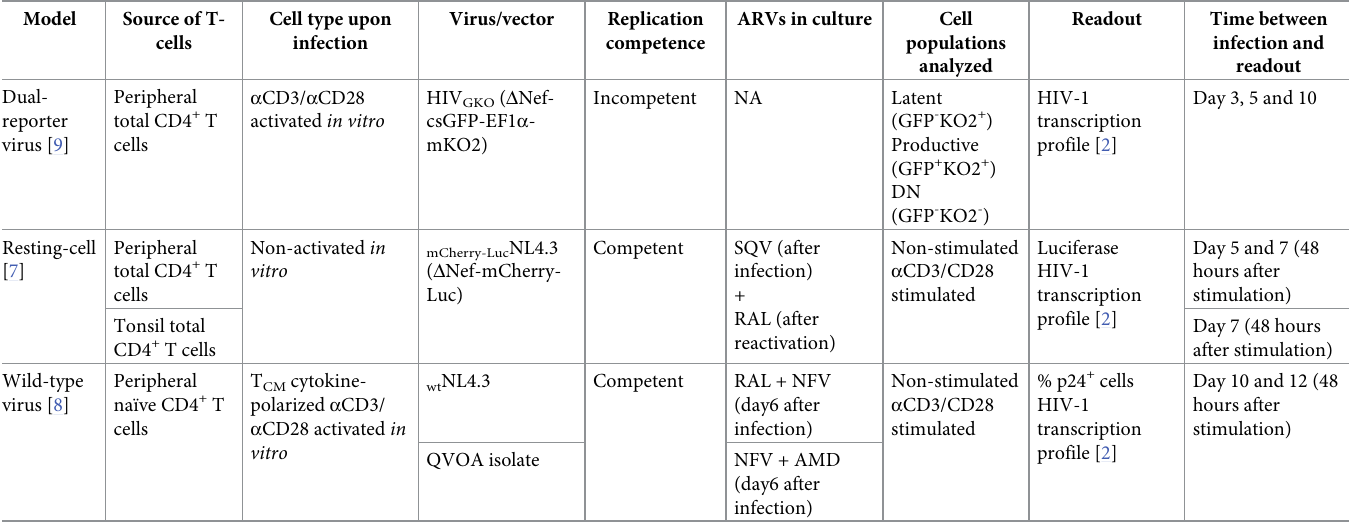
Table 1. Properties of the primary cell models of HIV-1 latency used in this